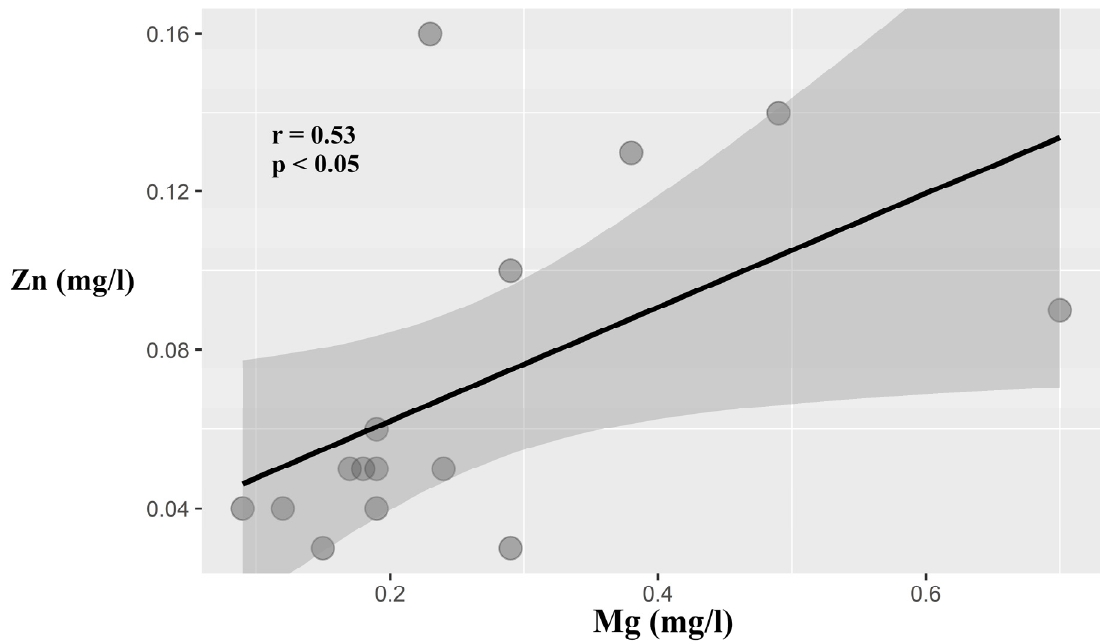
Figure 2. Scatter plot of correlation between Mg and Zn in third enamel layer.